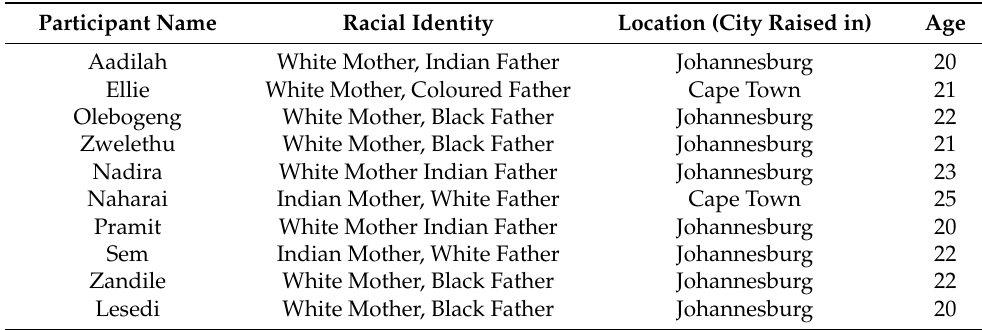
Table 1. Participant biographical